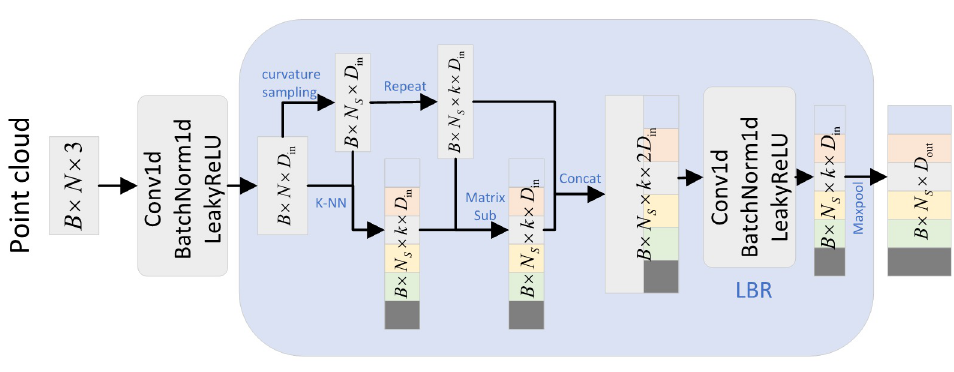
Figure 3. Neighborhood aggregation strategy framework diagram.